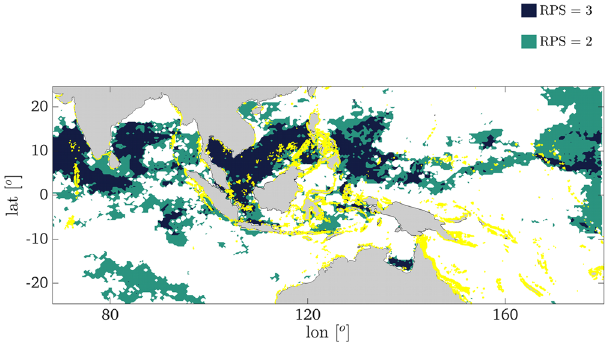
Fig. 5 Recovery potential score ( RPS) over 1993 – 2017. Dark blue (green) areas identify domains with RPS = 3 (RPS = 2), while known reefs are in yellow. In the Indian Ocean, the northern Maldives Islands, the Laccadive archipelago, and the reefs around Sri Lanka, together with smaller areas to the south-west of Thailand, the southern Nicobare Islands, and western Sumatra have a high RPS. In the South China Sea, recovery is likely along the coasts of southern Vietnam, west Cambodia, and southern Thailand, and around Riau Islands and northern Spratly Islands. A portion of reefs in the Indonesian Bangka-Belitung province has also a high RPS, along with reefs in central Java. In the northern CT, only reefs in the Sulu Sea have a high RPS , while in the central CT the Maluku Islands and Western Papua, Nusa Tenggara (eastern Indonesia) and south-eastern Sulawesi show good recovery potential. Finally, high RPS values are found to the south-east of the Philippines, in a small portion of northern Australia, and in some Paci fi c islands such as Palau, the western Federate States of Micronesia, and to a lesser extent the southern Marshall Islands and